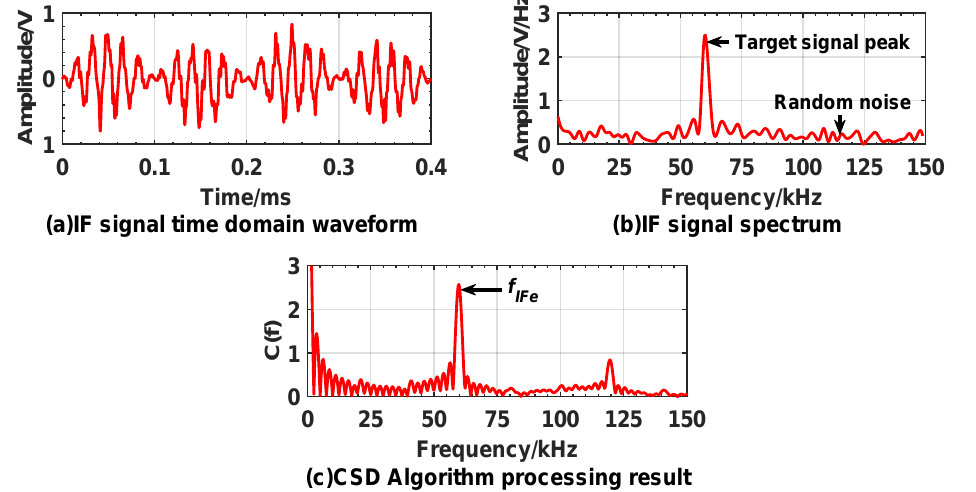
Figure 11. Experiment result when expected distance is 9 m with no smoke interference; ( a ) is time domain waveform of IF signal; ( b ) is spectrum of IF signal; ( c ) is processing results of the CSD